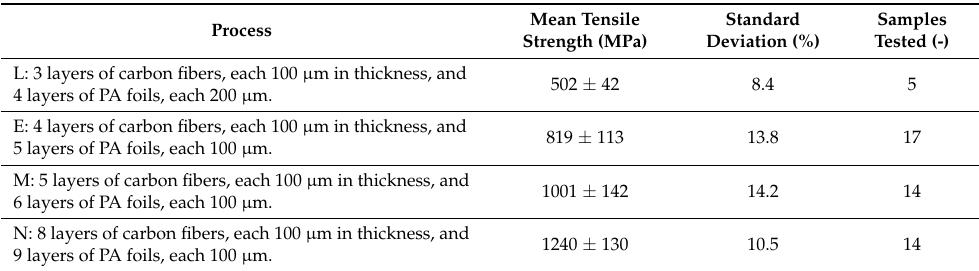
Table 5. Mean tensile strength and standard deviation of the ultrasonically fabricated CFRP samples measured within tensile